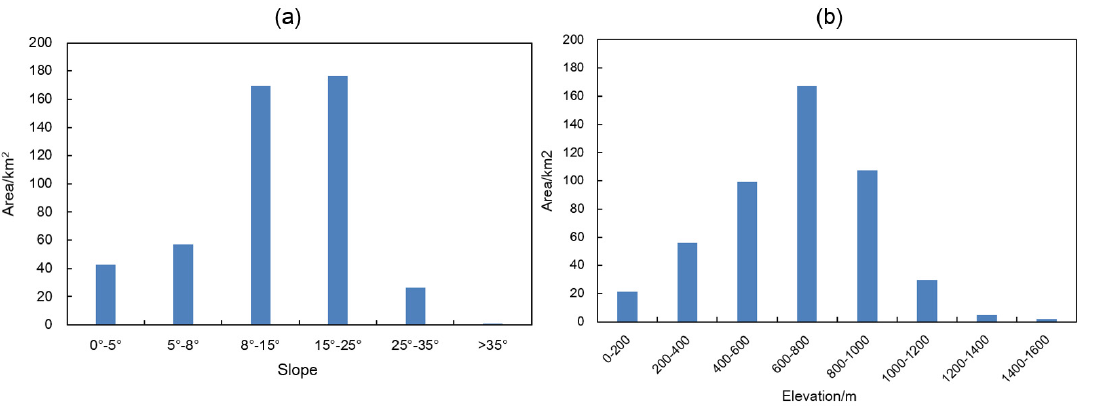
Figure 11. Spatial distribution characteristics of tea plantations: ( a ) The spatial distribution of tea plantations in different slope zones on GF-2 images; ( b ) the spatial distribution of tea plantations at different elevations on GF-2